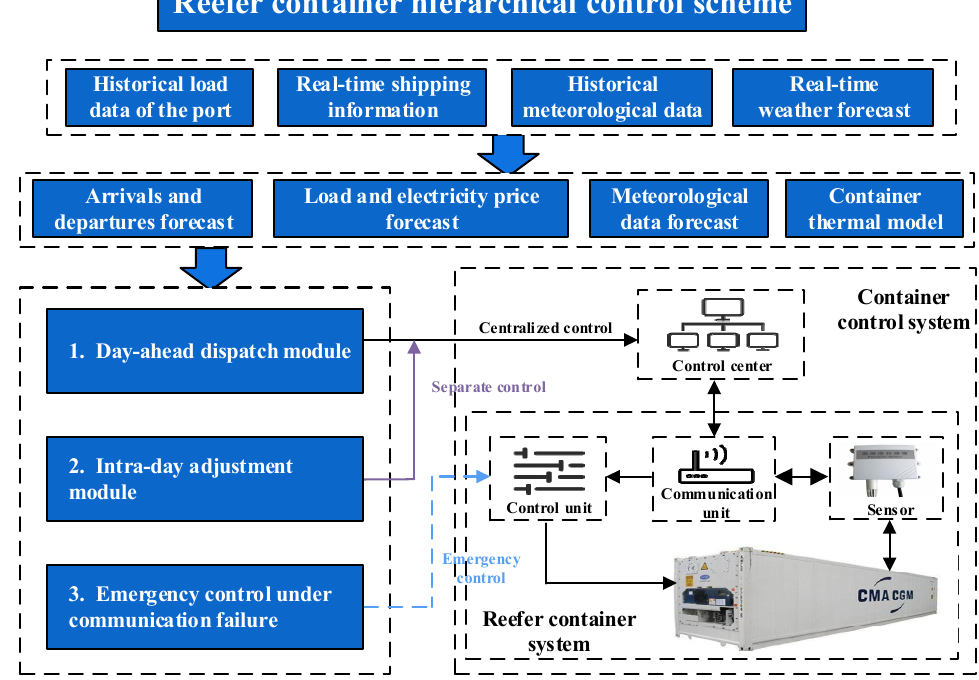
Figure 2. Reefer container hierarchical scheme.